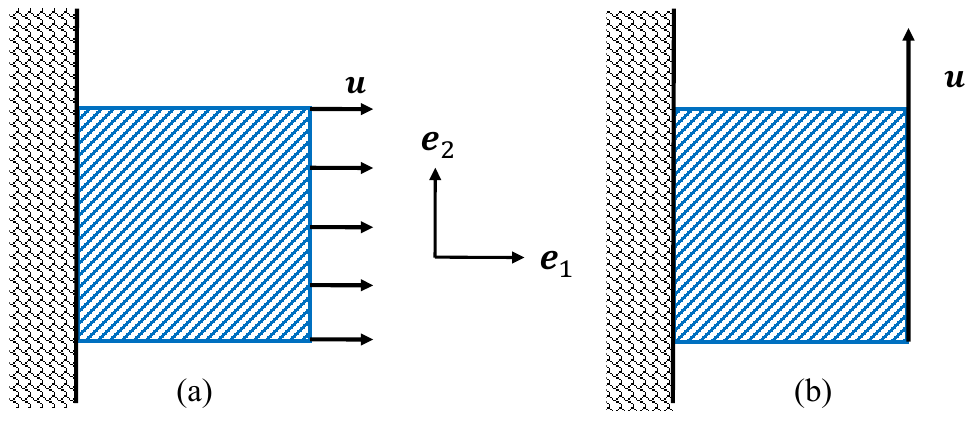
Figure 12. Illustration of ( a ) the tensile simulation and ( b ) the shear simulation from a 2D